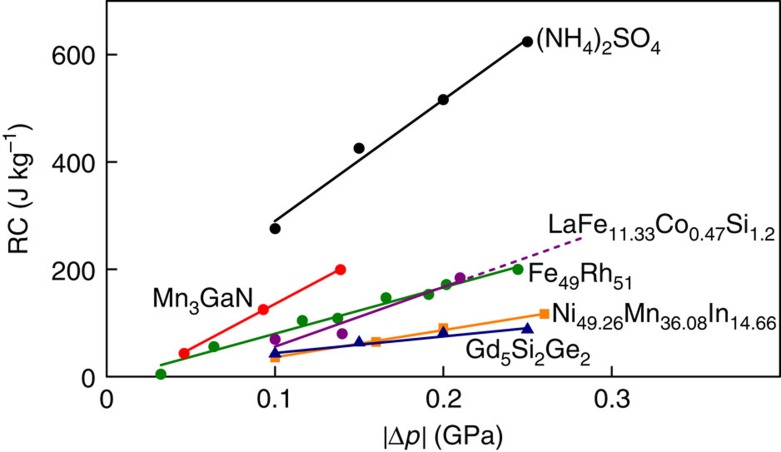
Refrigerant capacity RC for giant BC materials.For the materials in Table 1, we compare values of RC=|ΔS| × (FWHM of ΔS(T)) for selected pressure changes of magnitude |Δp|=|p−patm|∼|p|, using ΔS(T) for BC cooling, and constraining T to ensure reversibility (except for LaFe11.33Co0.47Si1.2, where only BC cooling data are available, and Ni49.26Mn36.08In14.66, where only BC heating data are available). Solid lines represent linear fits.